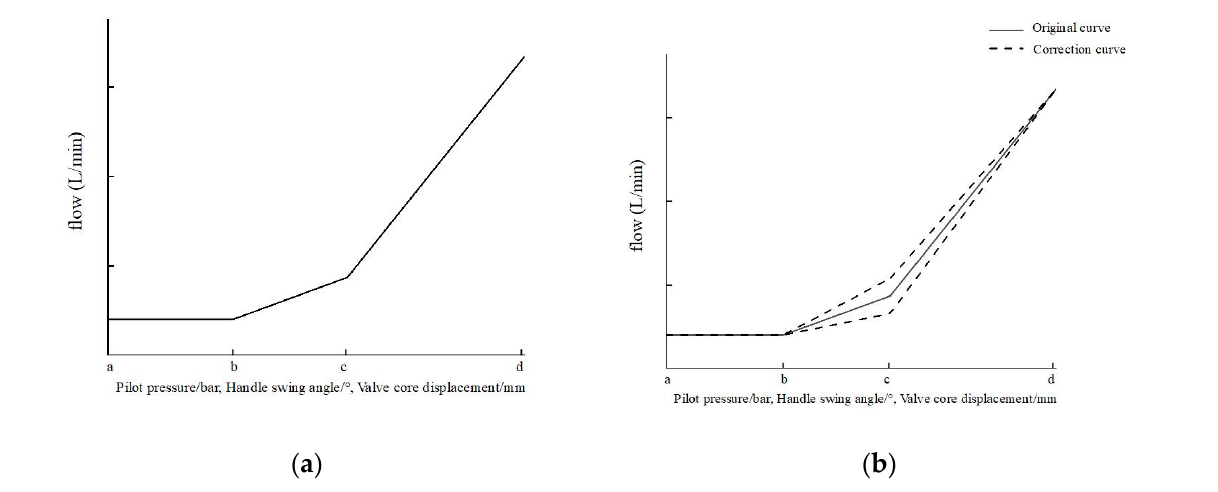
Figure 5. Speed regulation characteristic curve. ( a ) Speed regulation characteristic curve. ( b ) Double-break line type speed regulation characteristic curve.